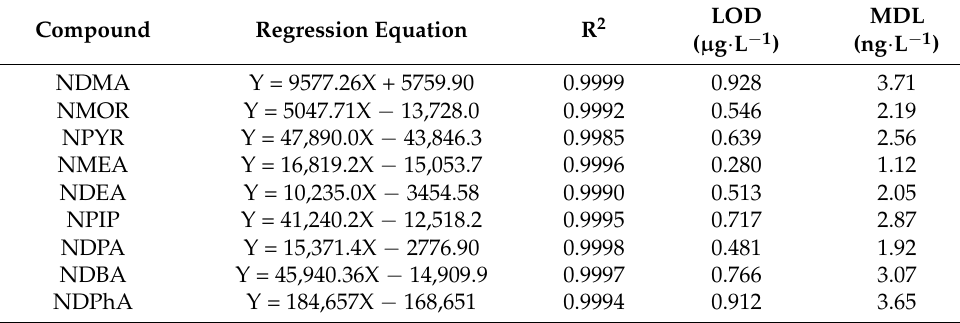
Table 4. Calibration curve parameters of nine N-nitrosamine compounds.